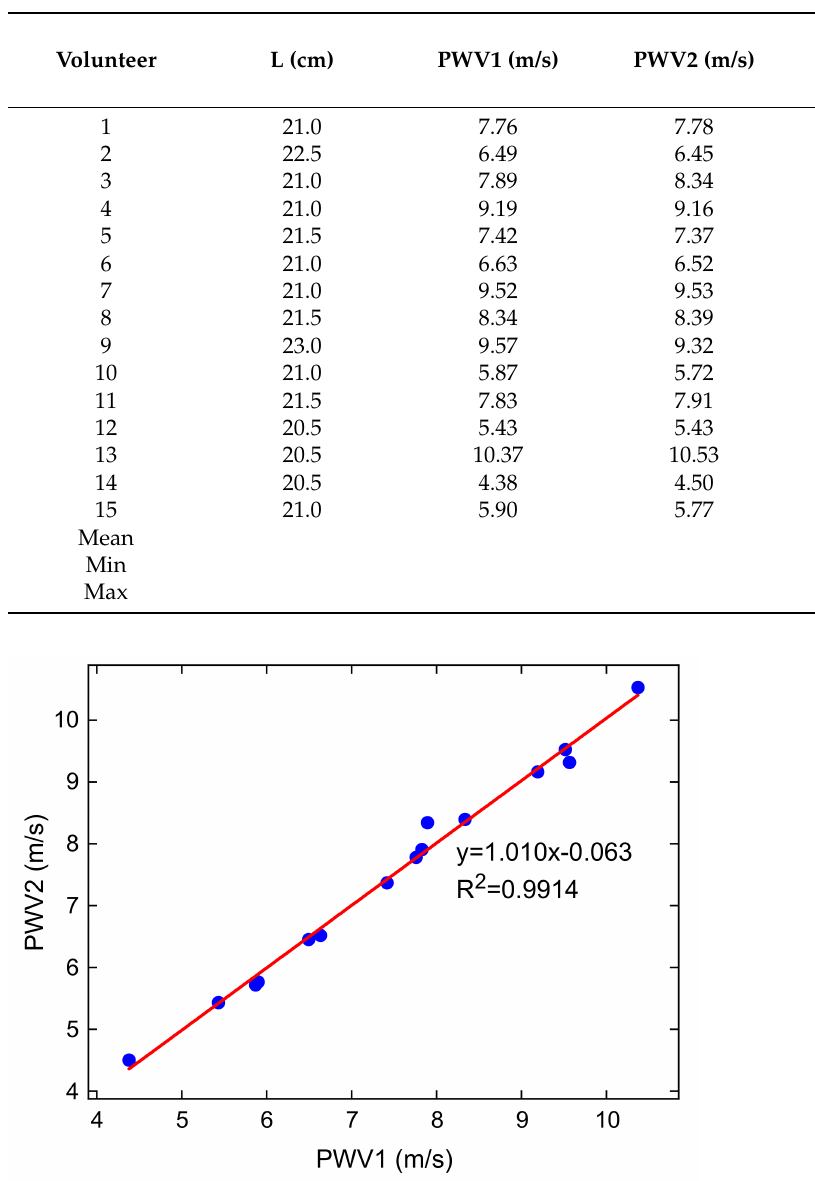
Table 2. PWV values in two measurements.